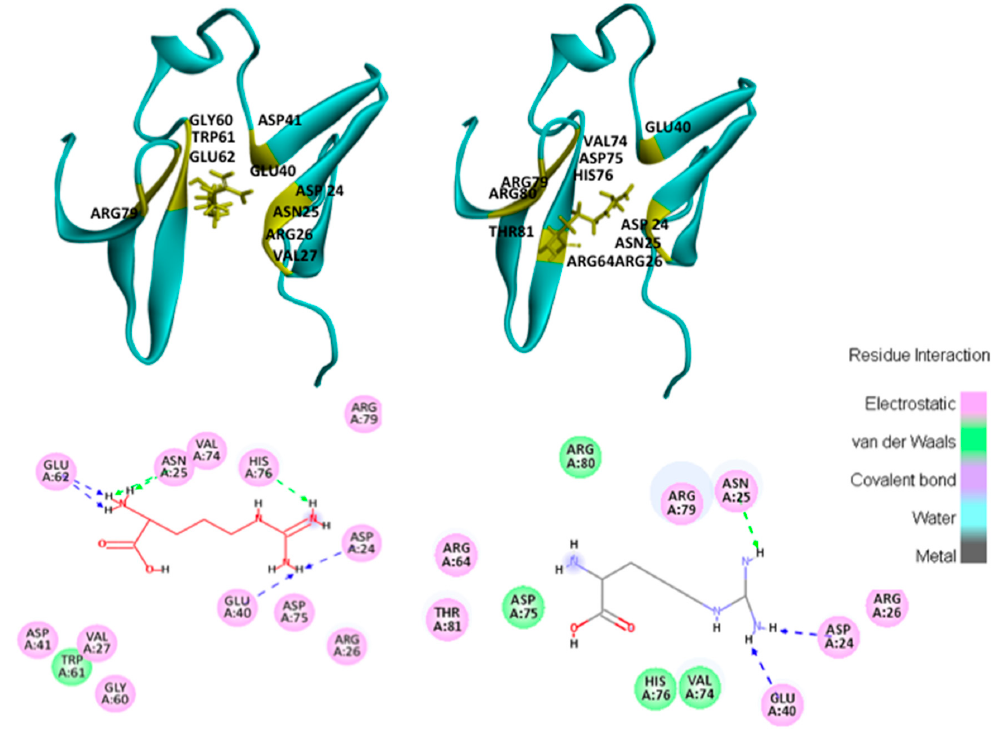
Figure 2. Lowest energy solutions of WW34 interactions with arginine (yellow tube representation). In yellow residues, less then 4 Å was found from the structure set as receptor (green ribbons). Results obtain with GLUE ( left ) and iGemDock ( right ). The diagrams in the bottom represent the interactions network between the arginine molecule and the surrounding residues from WW34, for the solutions above. The different colours correspond to the nature of the interaction as described in the legend.